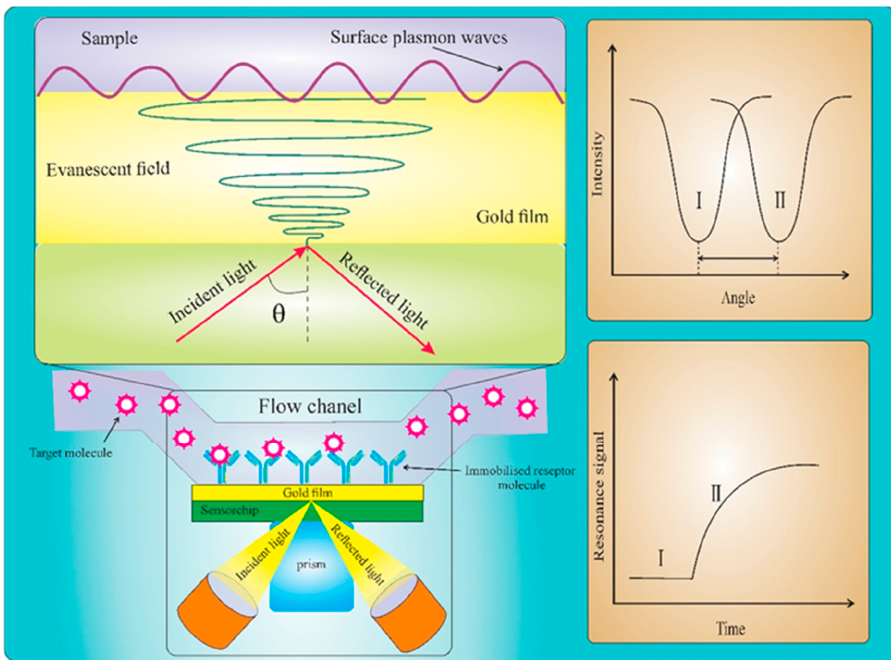
Figure 6. A schematic illustration of the conventional Kretschmann optical configuration for SPR biosensing and the associated angle shift and sensorgram plot of the resonance signal change with time ([67]).